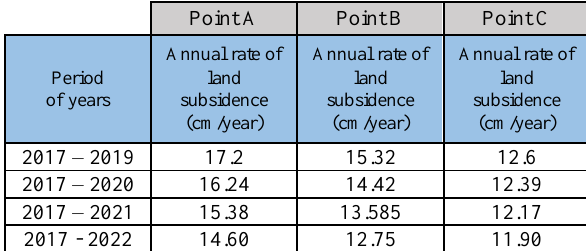
Table 3. Predicted rate of land subsidence at selected points A,